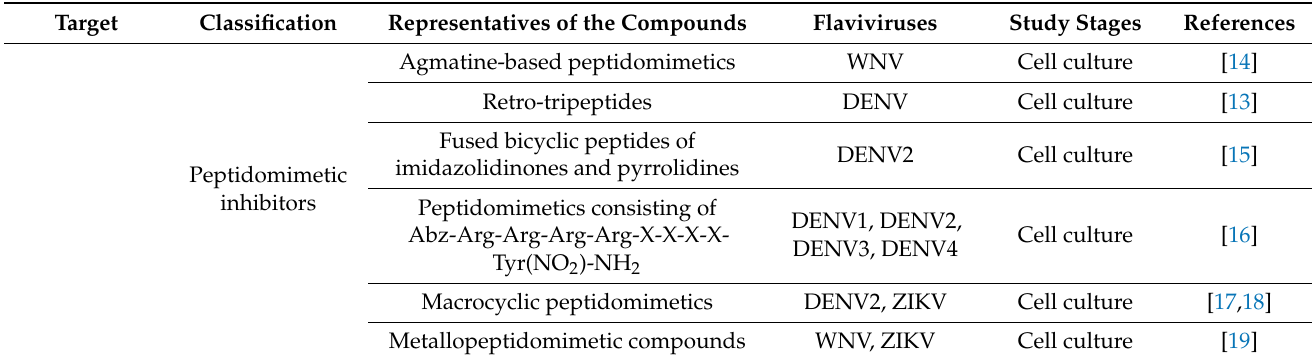
Table 1. The process of viral targets for antiflaviviral agents with their development stage. Target